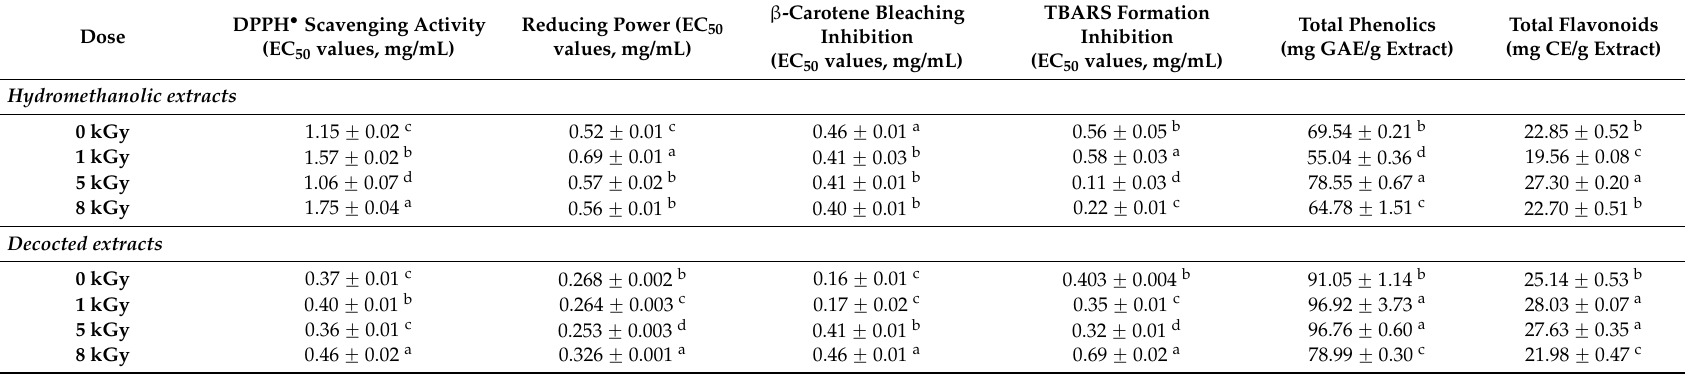
Table 2. Antioxidant activity of the hydromethanolic and decocted extracts prepared from the M. neglecta dry material submitted to gamma irradiation.